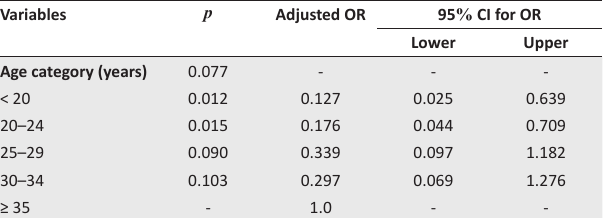
TABLE 4 : Logistic regression output for incidence or seroconversion of human immunodeficiency virus infection. Variables Adjusted OR 95 % CI for OR